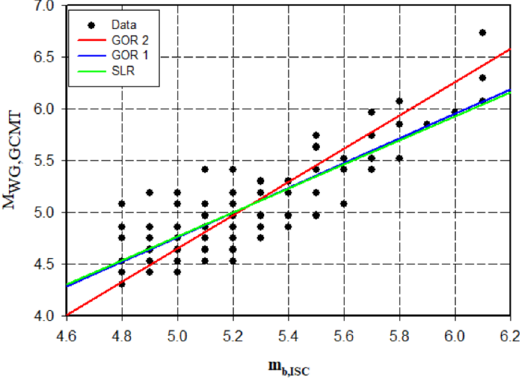
Figure 7. The (m b,ISC − M wg ) data, as well as the GOR1, GOR2, and SLR regression lines.